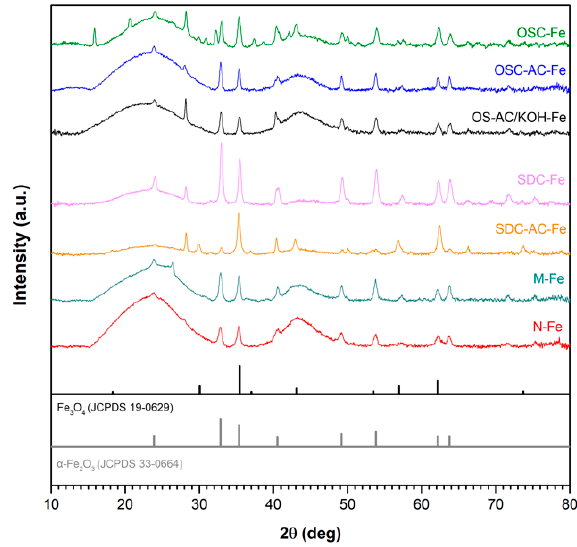
Figure 5. X-ray diffraction (XRD) patterns of the catalysts tested; standard patterns of Fe 3 O 4 and α -Fe 2 O 3 (JCPDS cards no. 19-0629 and 33-0664, respectively) are also presented.